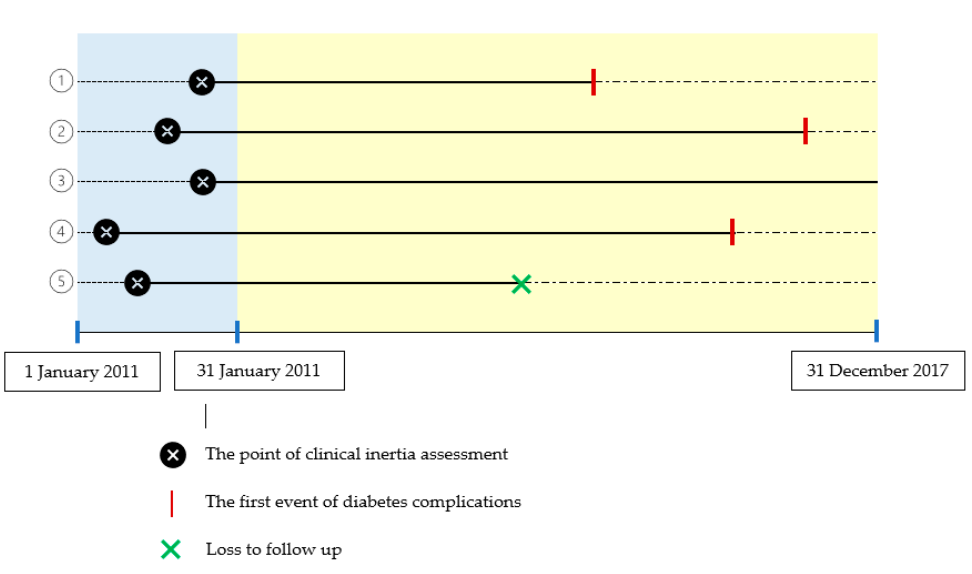
Figure 1. Clinical inertia assessment and diabetes complications. For example, of five patients who were assessed for clinical inertia in 2011 and were then followed up for diabetes complications from 2011 to 2017, three patients had diabetes complications (1, 2, 4); one patient had no diabetes complications until the end date of follow-up (31 December 2017) (3); one patient was lost to follow-up (5).